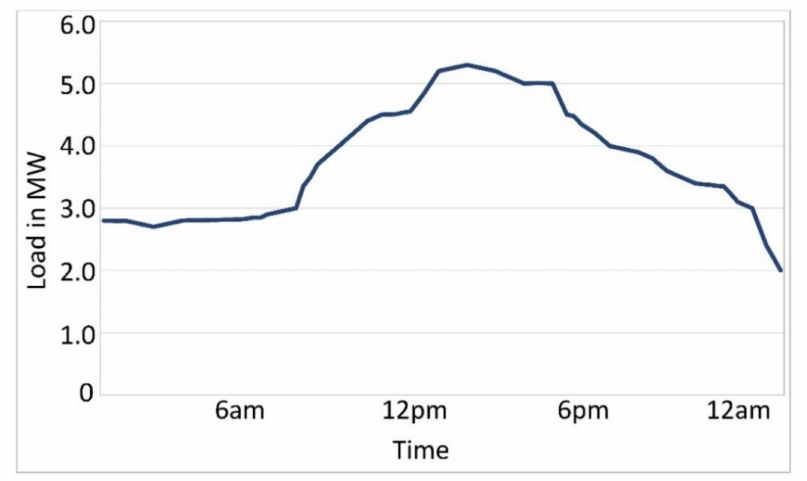
Figure 4. Time varying semester break load profile.